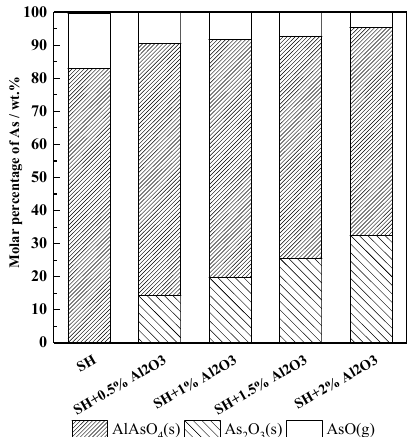
Figure 2. The influence of the addition of Al 2 O 3 on the distribution of arsenic under 1100 °C.